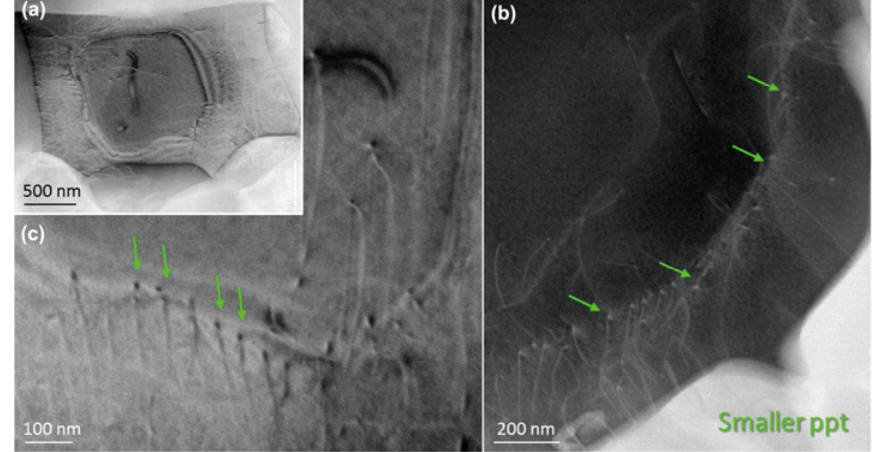
Fig. 9 TEM images of ZTC-B with arrows showing nano-precipitates at the core–shell interface in TiB 2